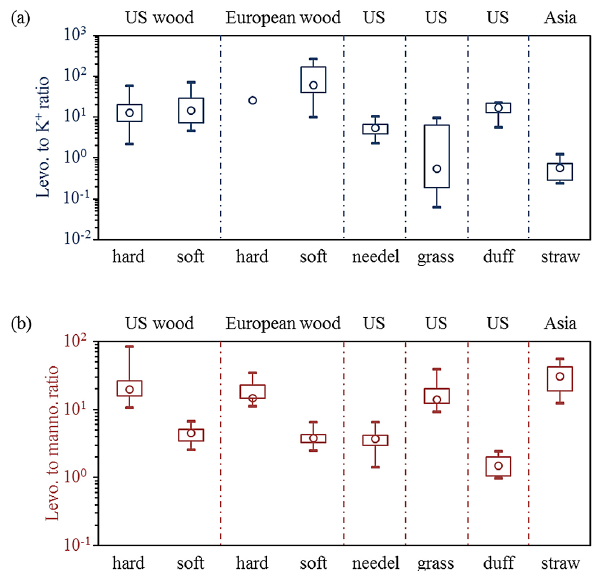
Fig. 8. Levoglucosan to K + (a) and levoglucosan to mannosan (b) ratios measured in source samples. The boundary of the box closest to and farthest from the x axis indicates the 25th and the 75th per- centile, respectively, while the whiskers above and below the box in- dicate the maximum and minimum. The circle within the box marks the median. Only the average value is shown for the levoglucosan to K + ratio of European hardwood since few data are available.